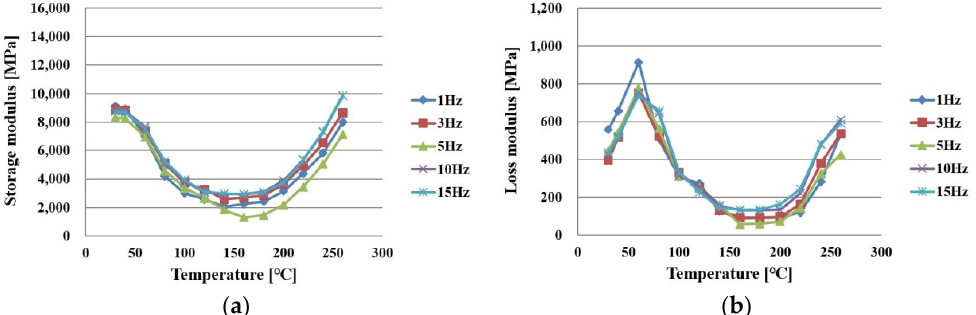
Figure 9. Measurement results of PPG in a y direction under curing as a function of frequency: ( a ) storage modulus; ( b ) loss modulus.